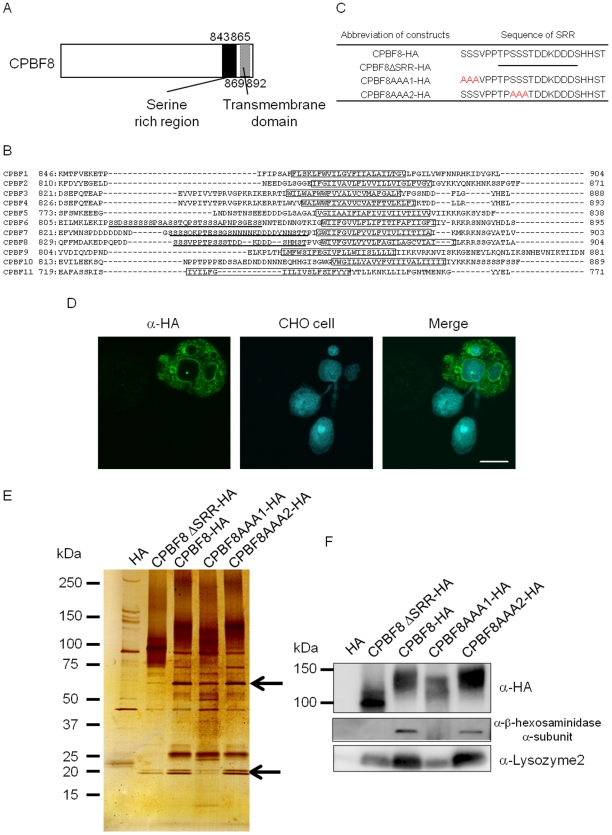
The serine-rich region of CPBF8 is involved in the binding with β-hexosaminidase α-subunit and lysozymes.(A) Schematic diagram of the serine-rich region and transmembrane domain in CPBF8. Numbers indicate amino acid positions from the amino terminus. The filled or hatched box depicts the serine rich region or the transmembrane domain, respectively. (B) Comparison of the carboxyl-terminal region of CPBF proteins. Boxes indicate the putative transmembrane domain. The serine-rich region is underlined. (C) The amino acid sequences of the wild-type and mutated serine-rich regions (SRR). Note that the entire SRR was deleted in CPBF8ΔSRR-HA. The first or second stretch of three serine residues within SRR were substituted with alanines in CPBF8AAA1-HA and CPBF8AAA2-HA, respectively. (D) Localization of CPBF8ΔSRR-HA to phagosomes. Amoebae were incubated with Cell Tracker Blue-stained CHO cells (blue) for 60 min, fixed, and reacted with anti-HA antibody (green). Bar, 10 µm. (E–F) Isolation and identification of binding proteins of CPBF8-HA, CPBF8ΔSRR-HA, CPBF8AAA1-HA, and CPBF8AAA2-HA. Lysates of CPBF8-HA, CPBF8ΔSRR-HA, CPBF8AAA1-HA, and CPBF8AAA2-HA transformants were mixed with anti-HA-antibody-conjugated agarose, washed, and eluted with HA peptide. Immunoprecipitated samples were separated on SDS-PAGE and silver stained (The upper and lower arrow indicated that β-hexosaminidase α-subunit and lysozymes, respectively. (E), or blotted and reacted with anti-HA, β-hexosaminidase α-subunit and lysozyme2 antibody (F).